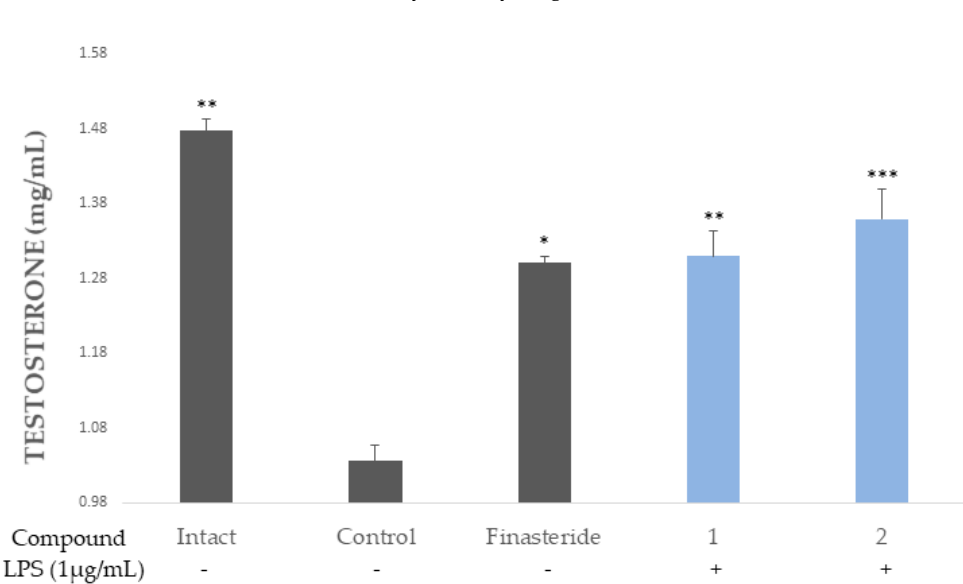
Figure 8. Compounds 1 and 2 inhibit 5 α -reductase activity. Values are expressed as the means ± standard deviations (SDs) from the triplicate measurements. * p < 0.05, ** p < 0.01, *** p < 0.001.